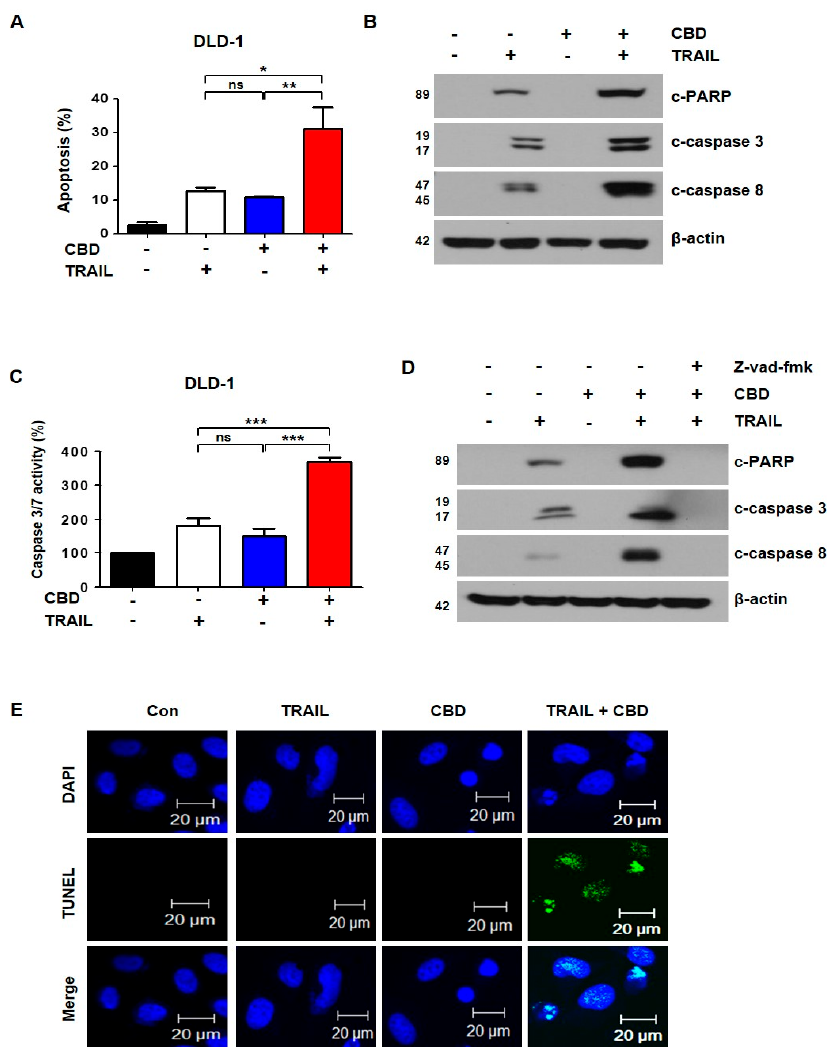
Figure 2. Effect of combined cannabidiol and TRAIL on TRAIL-induced apoptosis of DLD-1 cells. ( A ) DLD-1 cells were treated with 4 μ M cannabidiol and/or 10 ng/mL TRAIL for 24 h. Flow cytometry using double staining with annexin V and PI was performed. Bar graphs representing the proportion of apoptotic cells are shown. Data are expressed as means ± SEM. ( B ) Effect of combined treatment with cannabidiol and TRAIL on levels of apoptosis-associated proteins. ( C ) Caspase3/7 activities were measured by ELISA-based luminescence assays following treatment with cannabidiol and/or TRAIL. ( D ) DLD-1 cells were treated with cannabidiol and/or TRAIL in the absence or presence of 25 μ M z-VAD-fmk for 24 h. PARP, caspase-3, caspase-8, and β -actin protein expression levels were determined by western blot. β -actin was used as a loading control. ( E ) Terminal deoxyribonucleotidyl transferase-mediated dUTP nick end labeling (TUNEL) assay was used to evaluate apoptosis in DLD-1 cells. Cells were pretreated with or without 4 μ M cannabidiol for 24 h and then exposed to TRAIL at 10 ng/mL for 4 h. * p < 0.05; ** p < 0.01; *** p < 0.001. CBD, cannabidiol; ns, not significant.